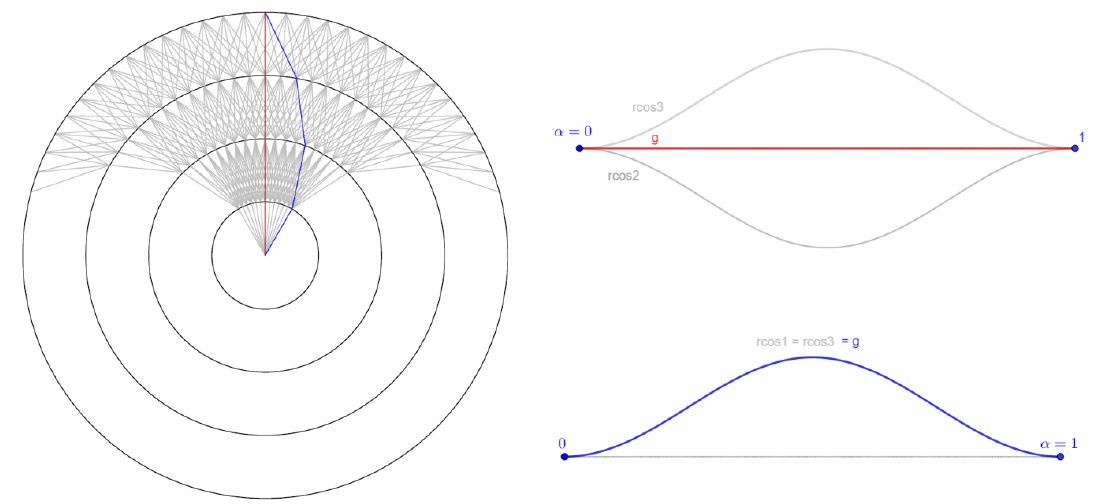
Figure 5. Two paths to the same exit and the associated biais